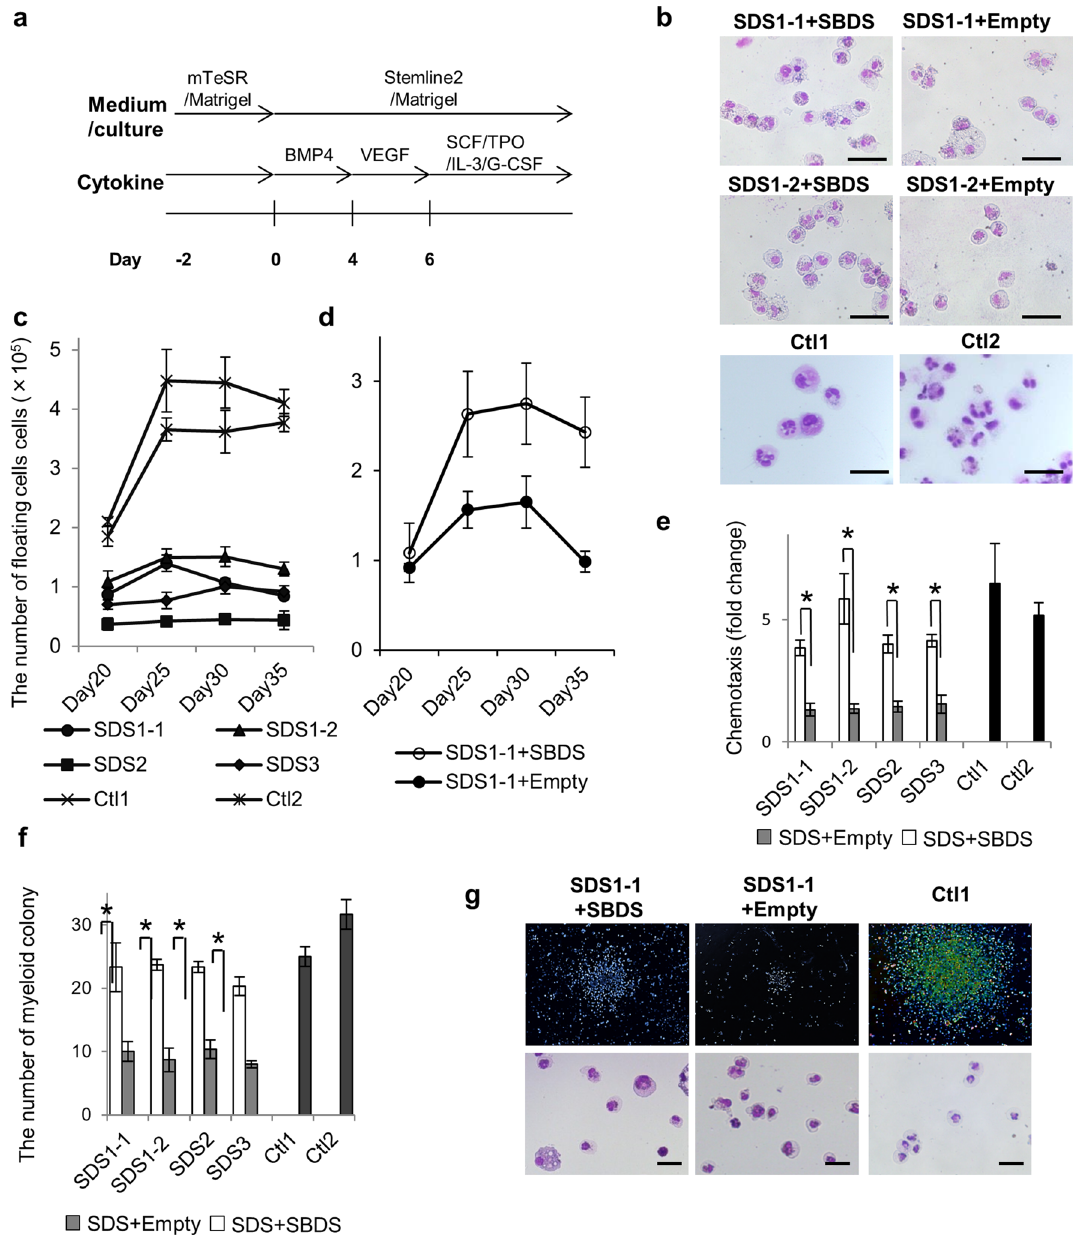
Figure 2. Transduction of SDS-iPSCs. ( a ) Construction of lentiviral vectors containing DsRed alone (PBCl- EF1a-DsRed-PuroR-pA) or SBDS cDNA and DsRed (PBCl-EF1aSBDS-IRES2-DsRed-PuroR-pA). ( b ) Western blotting analysis of SBDS protein in SDS-iPSC clones transduced with SBDS or empty (DsRed alone) vector. TF2B was used as a loading control. “ + SBDS” indicates iPSC clones transduced with SBDS vector. ( c ) Representative polysome profiling of SDS-iPSC clones transduced with SBDS or empty vector. ( d ) 80S:40S ratio in SDS-iPSC clones transduced with SBDS or empty